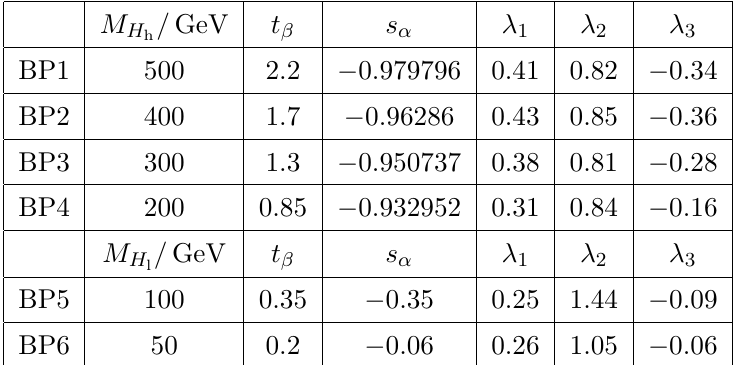
= 125 : 09 GeV. The Higgs h